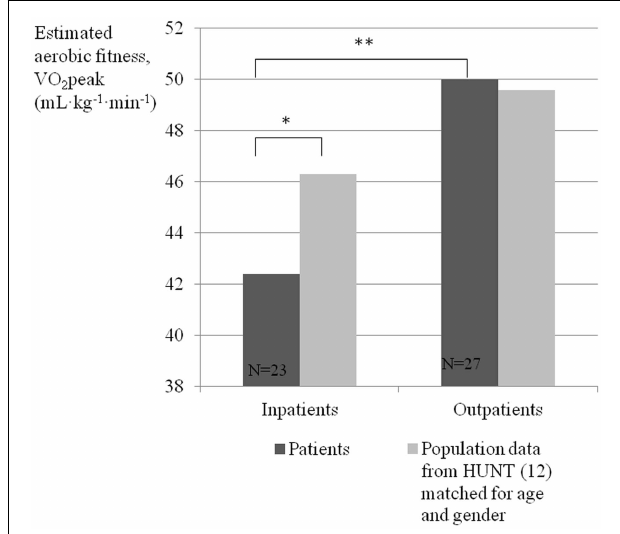
FIGURE 1 | EstimatedVO 2 peak for inpatient and outpatient with severe mental disorder, compared to a matched population average . * p =0.003. ** p